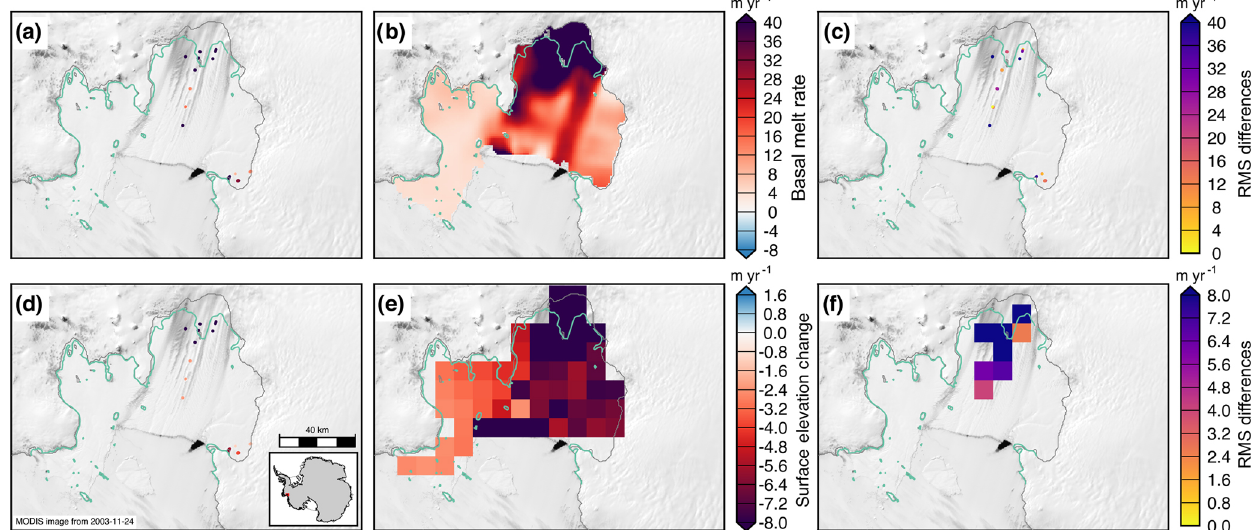
Figure 10. Estimated basal melt rates (a–b) and differences in melt rates (c) of the Pine Island Ice Shelf from (a) NASA–CECS Pre-IceBridge and NASA Operation IceBridge over 2002–2009 and (b) from ICESat over 2003–2009 (Rignot et al., 2013). Estimated elevation change rates (d–e) and differences in elevation change rates (f) of the Pine Island Ice Shelf from (d) NASA–CECS Pre-IceBridge and NASA Operation IceBridge over 2002–2009 and (e) from ICESat over 2003–2009 after correcting for strain (Pritchard et al., 2012). MEaSUREs InSAR- derived Antarctic grounded ice boundaries are denoted in gray (Mouginot et al., 2017b). The 1996 InSAR-derived grounding line locations from Rignot et al. (2016) are delineated in green. Plots are overlaid on MODIS images of Antarctic ice shelves provided by NSIDC (Scambos et al., 2001). The inset map denotes the location of the